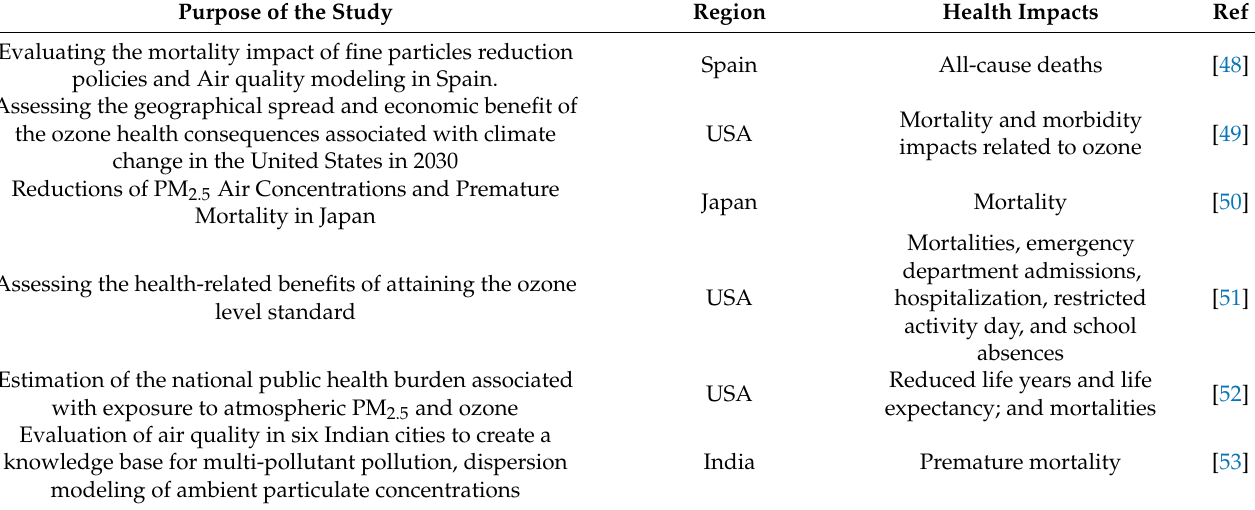
Table 1. Recent studies in the air pollution health risk